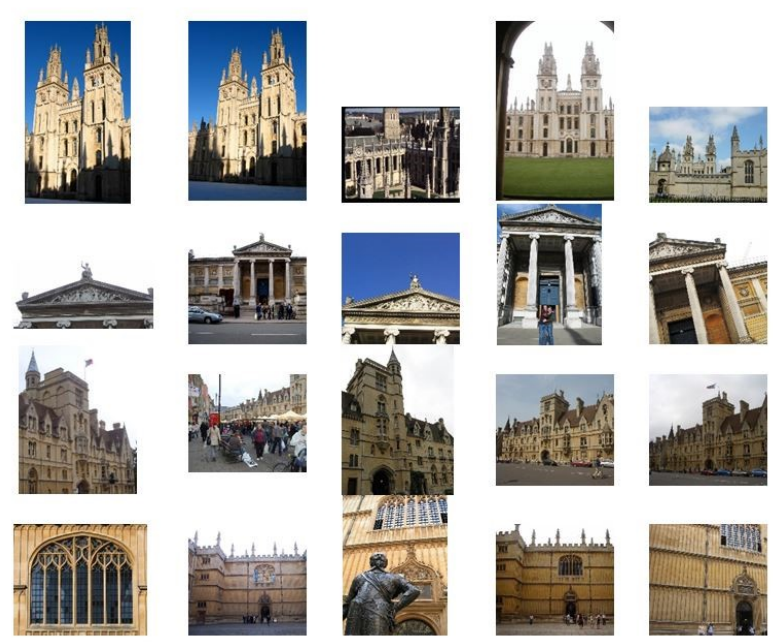
Figure 10. Several examples of detection results of the proposed method. The four queries are listed in the first column, and the corresponding top four ranked detection results of each query are shown in the following columns.